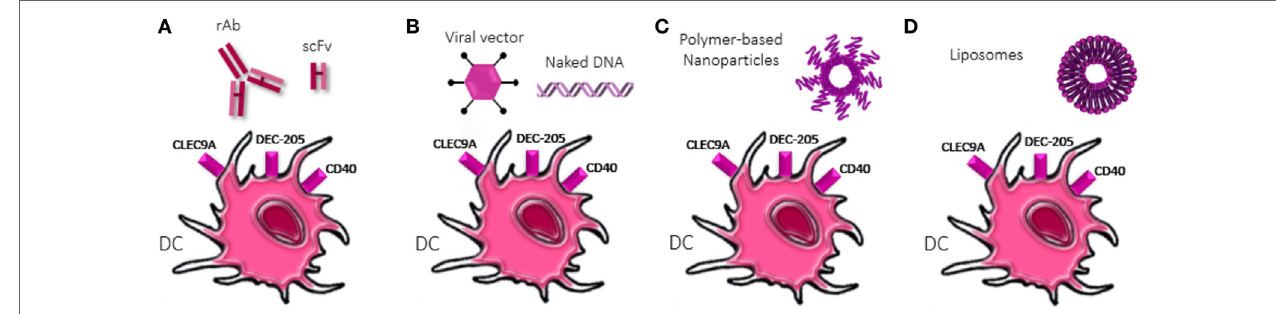
FiGURe 2 | Strategies of dendritic cells (DCs) targeting. Diverse approaches to deliver antigens to DCs are shown. (A) Recombinant antibody or single-chain variable fragment (scFv) specific for DC receptors are chemically conjugated with antigen and adjuvant molecules. scFv reduced dimension confers them higher tissue-penetrating properties. (B) Viral vector-based vaccines or naked DNA exploit the encoding machinery of DCs to translate antigens, adjuvants but also co-stimulatory molecules (“signal 2”) and cytokines (“signal 3”) increasing the activatory profile of DCs. Naked DNA could be delivered conjugated to nanoparticles (NPs) and liposomes. (C) Polymer-based NPs display physical and chemical properties that allow encapsulation or conjugation of antigens and adjuvants as well as ligands for specific DC receptors. Different polymer compositions provide diverse properties and dimension, allowing easy diffusion and/or retention in lymph node. (D) Liposomes allow both the encapsulation and intercalation in the phospholipid bilayer of antigens and adjuvants, depending on their chemical properties, as well as the functionalization of the surface with ligands of DC